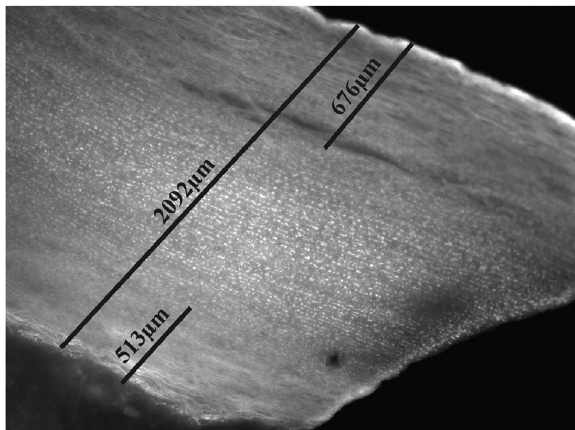
Fig. 7 Decellularization of small aortic tissue piece using 0.5% SDC/ SDC for 24 h. Figure 7 shows the representative image of a DAPI stained small sized aortic tissue piece (1.5 × 1.5 cm) after decellular- ization with 0.5% SDC/SDS for 24 h. Lines are indicating aortic wall diameter (2091.99 µm) and decellularization ef fi ciency at the intimal side (676.42 µm) and adventitial side (513.67 µm). Decellularization of smaller aortic pieces signi fi cantly increases ef fi ciency. Image was taken at a magni fi cation if ×5